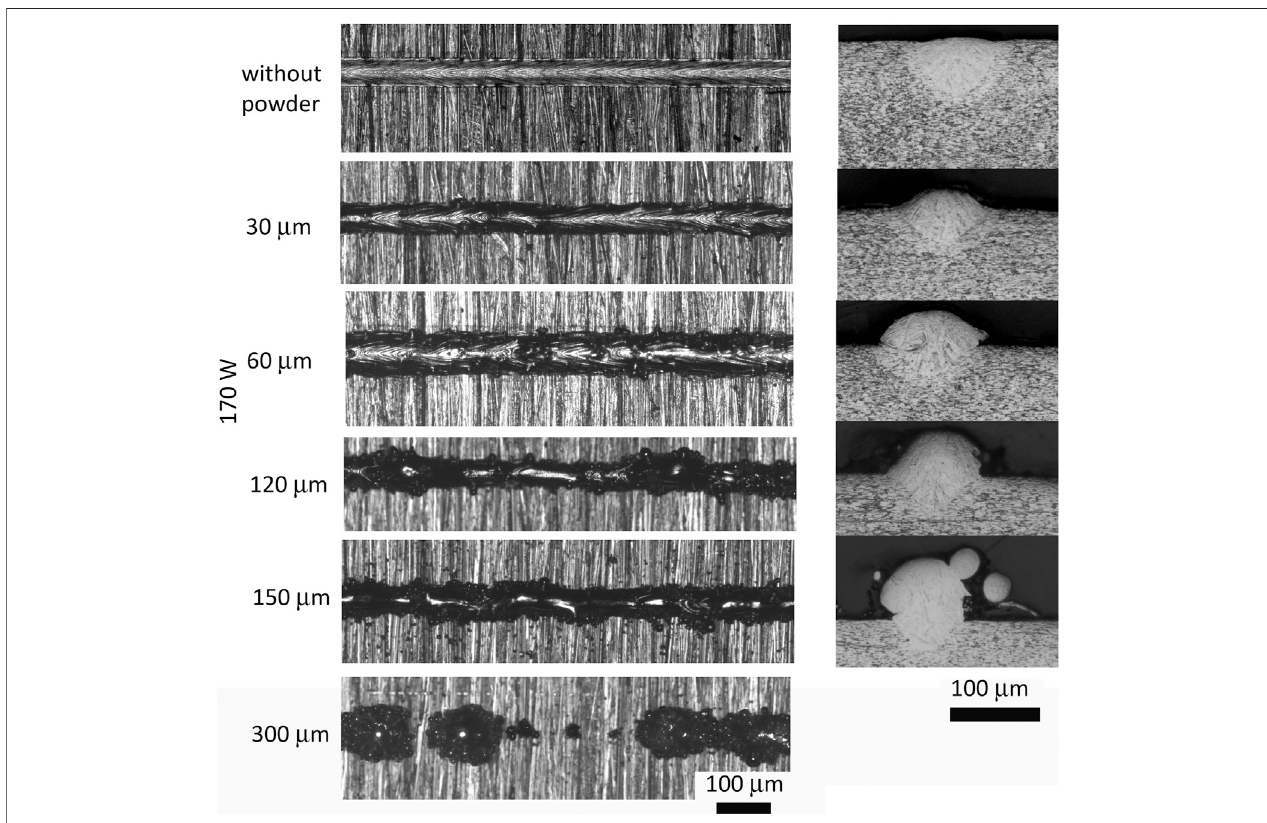
FIGURE 4 | Typical view of single tracks on the substrate at different powder layer thickness: top view (A) and cross-sections (B) , scanning speed of 1.2 m/s and laser power of 170 W.